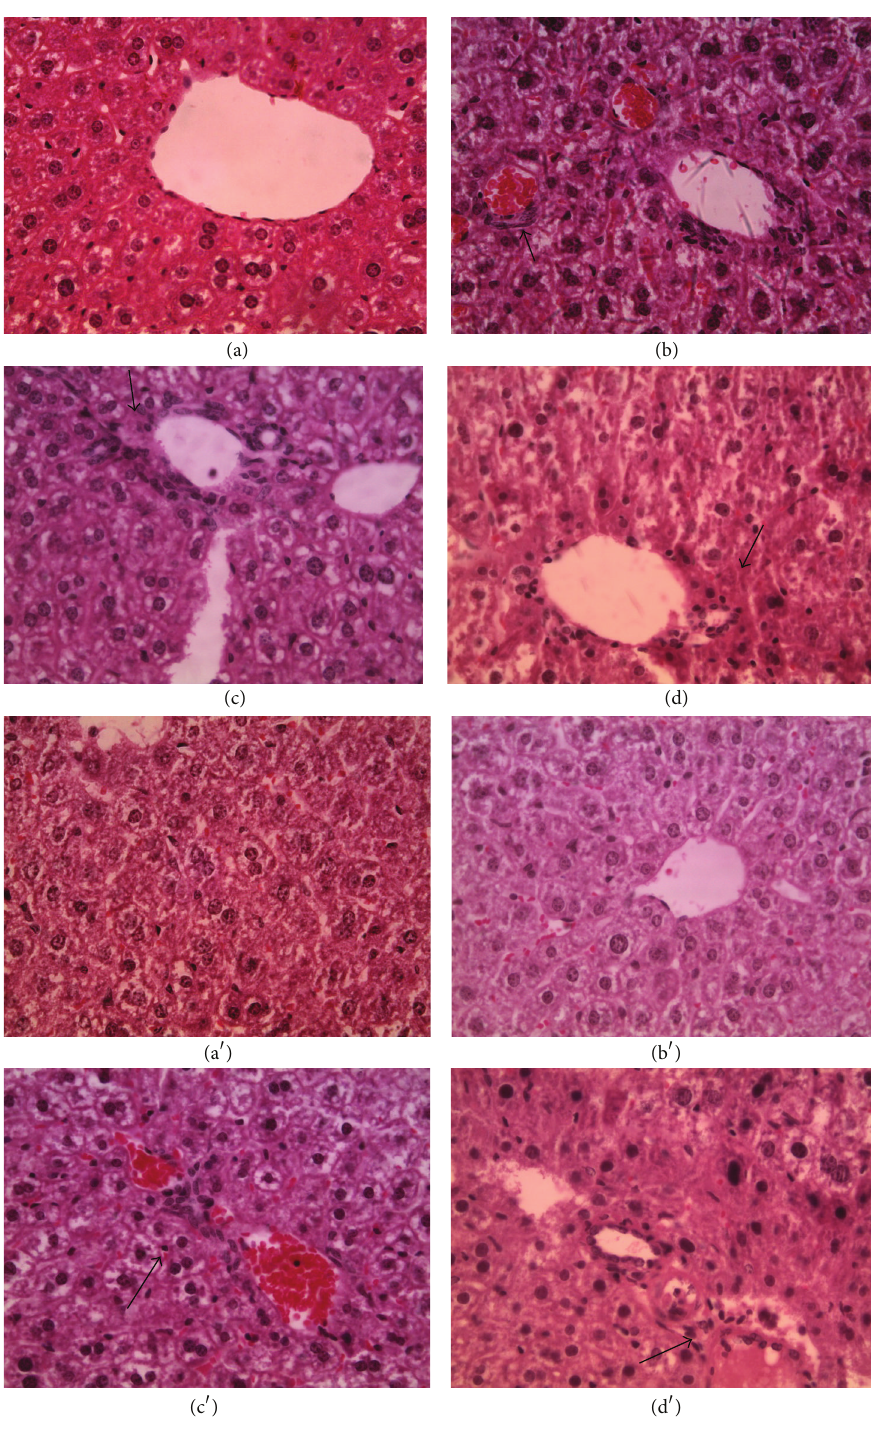
Figure 5: Hepatic sections. ((a) and (a 󸀠 )) Control, magnification 40x; ((b) and (b 󸀠 )) low concentration, magnification 40x; ((c) and (c 󸀠 )) medium concentration, magnification 40x; ((d) and (d 󸀠 )) high concentrations, magnification 40x. (a), (b), (c), (d) males and (a 󸀠 ), (b 󸀠 ), (c 󸀠 ) and (d 󸀠 ) females. Arrows indicate lymphoid cells aggregates, usually present during inflammation